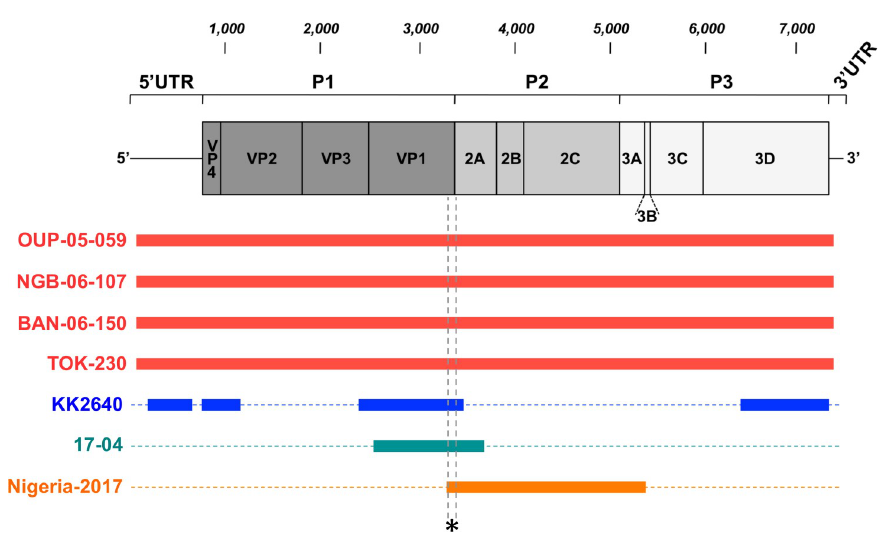
Fig 4. Schematic representation of the genetic data available for the known EV-D111 strains. Solid bars cover the genomic regions whose sequences are available. The asterisk indicates the short region used to draw the phylogram featured as S1